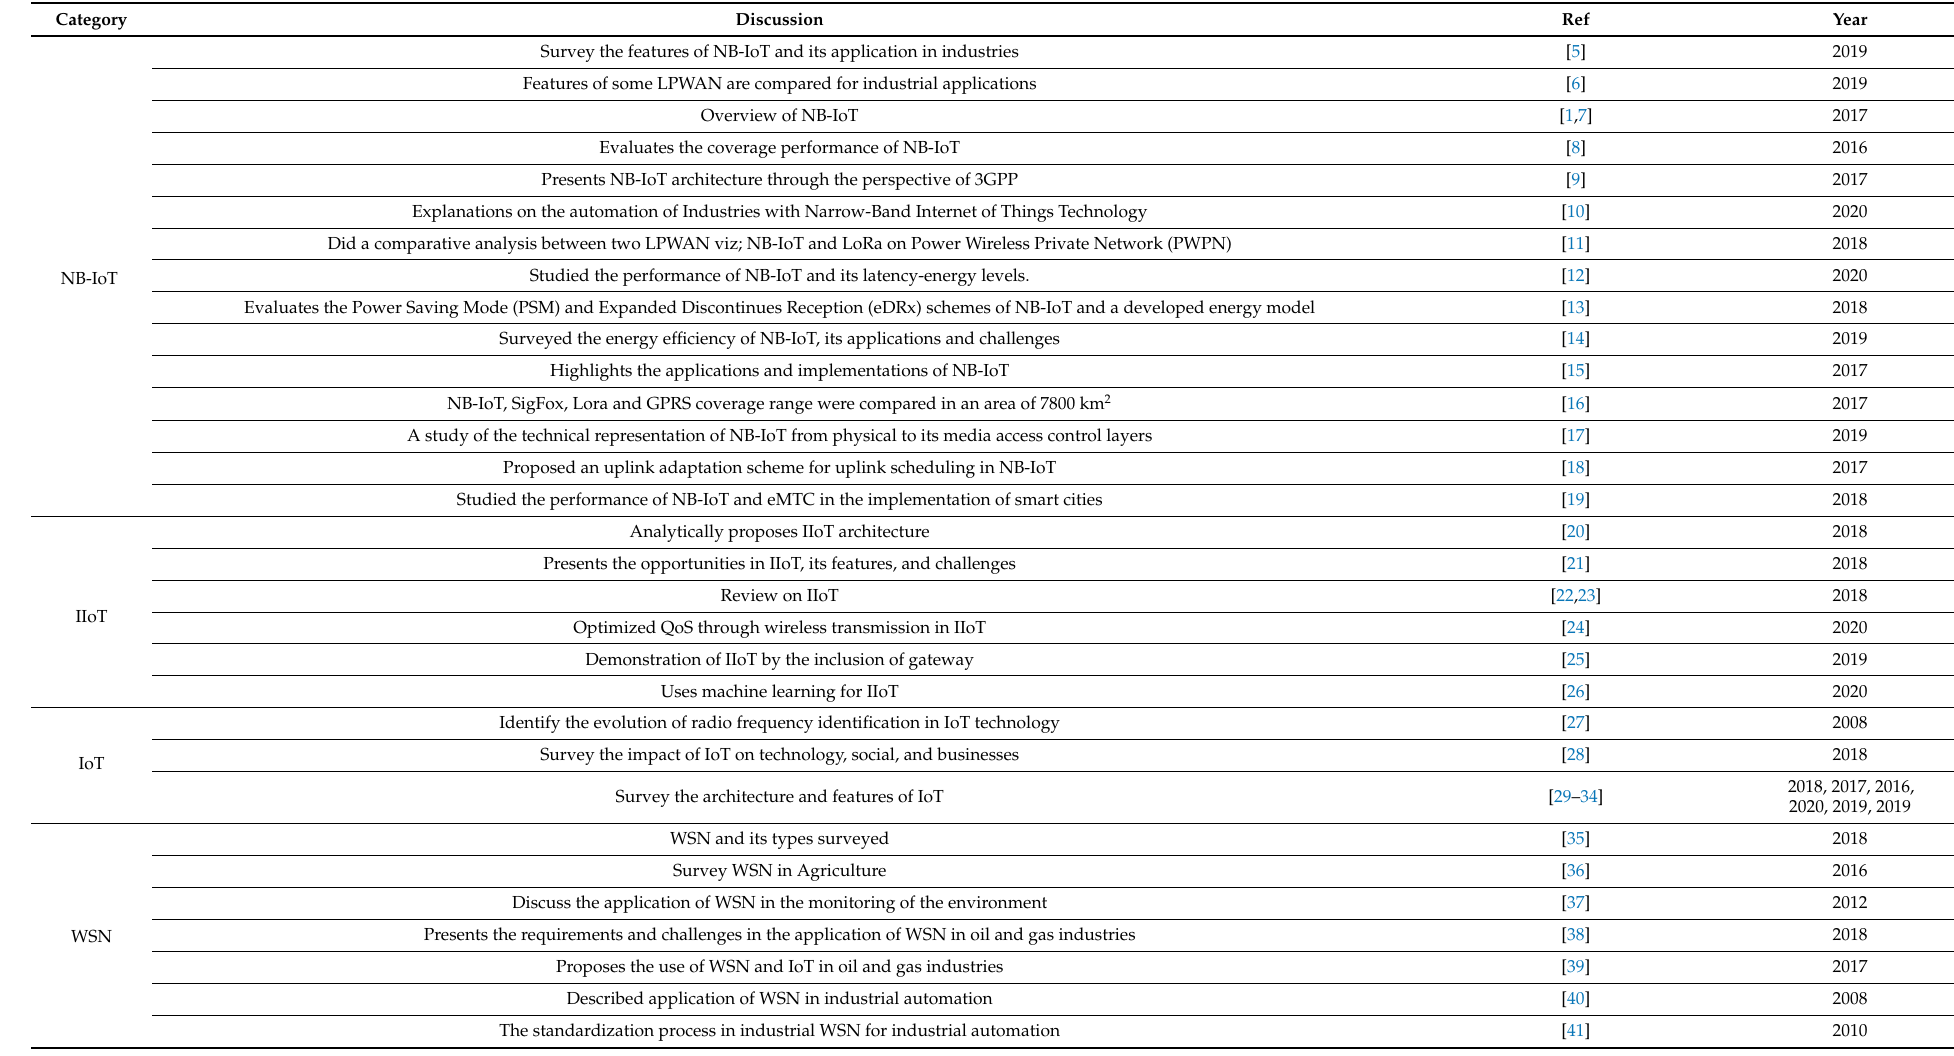
Table 1. Highlights of some research